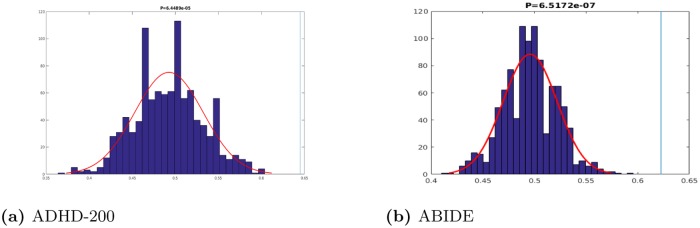
Permutation tests.